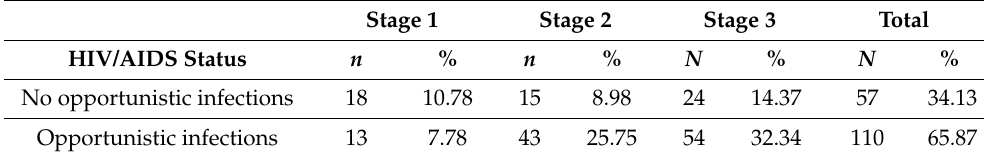
Table 7. Distribution of opportunistic infections by CDC stage in our study group.